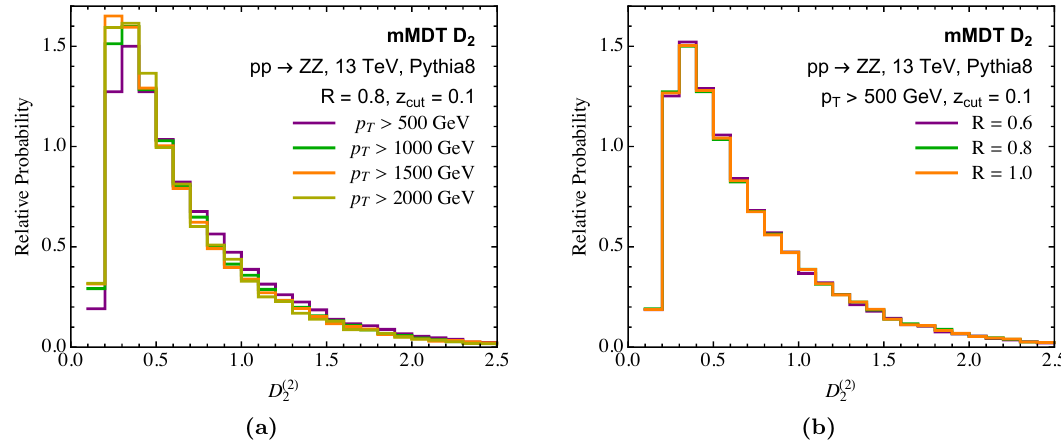
Figure 16. Distributions of D (2) measured on mMDT groomed hadronically-decaying Z jets with 2 z cut = 0 : 1 from the process pp ZZ at the 13 TeV LHC. The groomed jet mass is restricted to lie ! in the range 80 GeV < m J < 100 GeV. (a) Distributions of D (2) for various p T cuts, with the jet 2 radius (cid:12)xed to R = 0 : 8. (b) Distributions of D (2) for various jet radii R , with the jet p T cut (cid:12)xed 2 to p T > 500